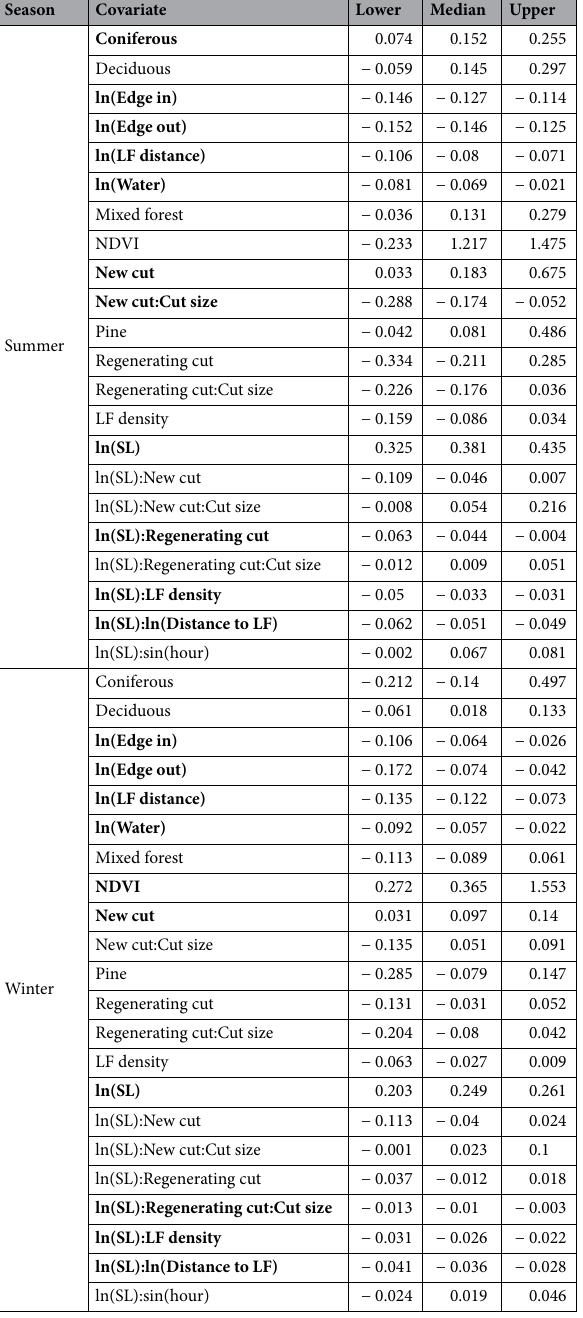
Table 2. Seasonal habitat selection and movement beta coefficient estimates with lower and upper 95% confidence bounds for the global integrated step selection analysis model in summer (April 1–September 30) and winter (October 1–March 31) in Prince George South, 2018–2020. ‘:’ denotes an interaction between covariates. Bolded terms indicate significance (i.e. beta estimates do not overlap 0). ln() = log-transformed covariate. SL step length, LF linear